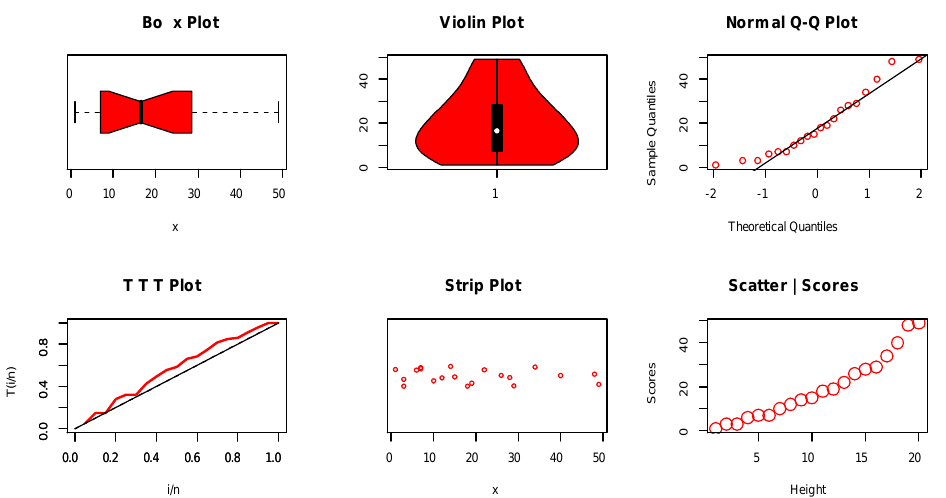
Figure 11. Non-parametric visualization plots for LR data. Figure 11 . Non-parametric visualization plots for LR data. The MLE with their SE, CI for the parameter(s), and GOF test for LR data are listed in Tables 10 and Table 11. The GOF test for LR data. 11. Table 10 . The MLE, SE and CI for LR data.